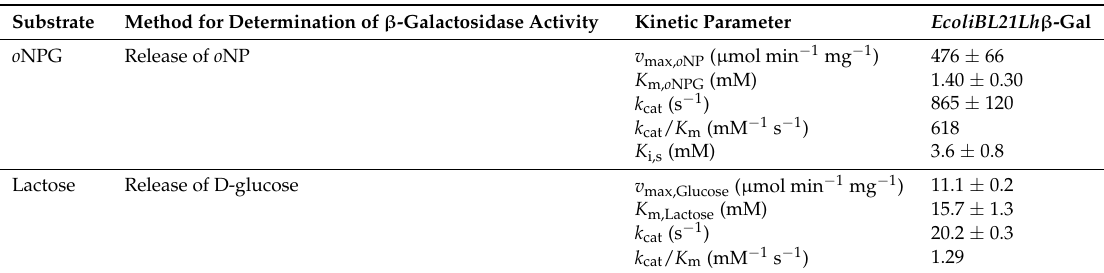
Table 1. Kinetic parameters of recombinant β -galactosidase from L. helveticus ( EcoliBL21Lh β -gal) for the hydrolysis of o -nitrophenyl- β - D -galactopyranoside ( o NPG) and lactose.